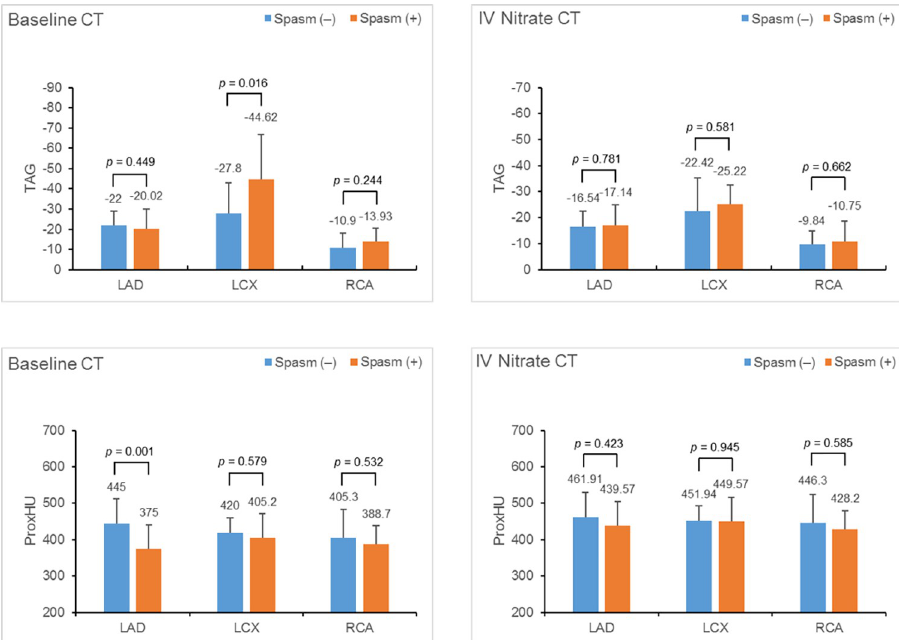
baseline CT. For IV nitrate CT, there was no significant difference in the TAG or ProxHU values between the spasm (+) and (-) vessels for all three vessels. Spasm (-), patients without vessels showing spasm; Spasm (+), patients with vessels showing spasm; TAG, transluminal attenuation gradient; ProxHU, most proximal CT number of each coronary arteries; LAD, left anterior descending artery; LCX, left circumflex artery; RCA, right coronary artery.